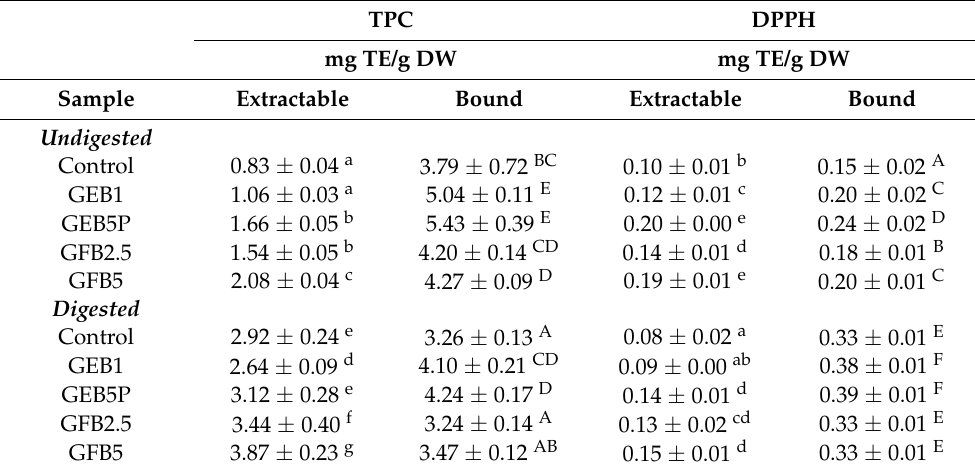
Results are expressed as the mean ± standard deviation. Means with different small letters within a column indicate significant differences between the content of extractable phenolics ( p < 0.05; Duncan’s multiple range test). Means with different capital letters within a column indicate significant differences between the content of bound phenolics ( p < 0.05; Duncan’s multiple range test). mg TE/g DW: mg Trolox equivalents per g dry weight.